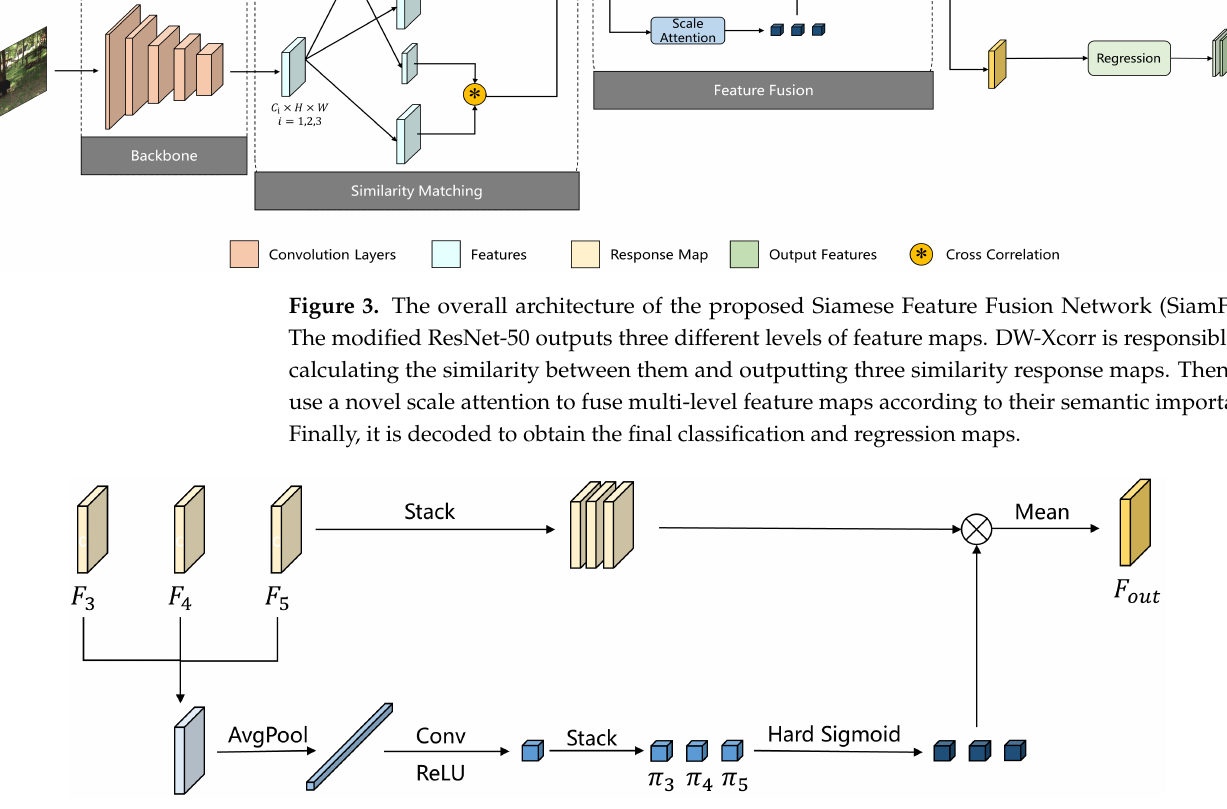
Figure 4. Feature fusion